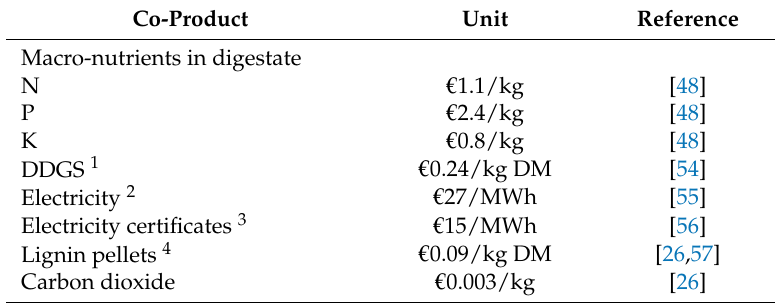
Table A14. Economic value of co-products the production of biogas and ethanol from wheat grain and straw respectively.